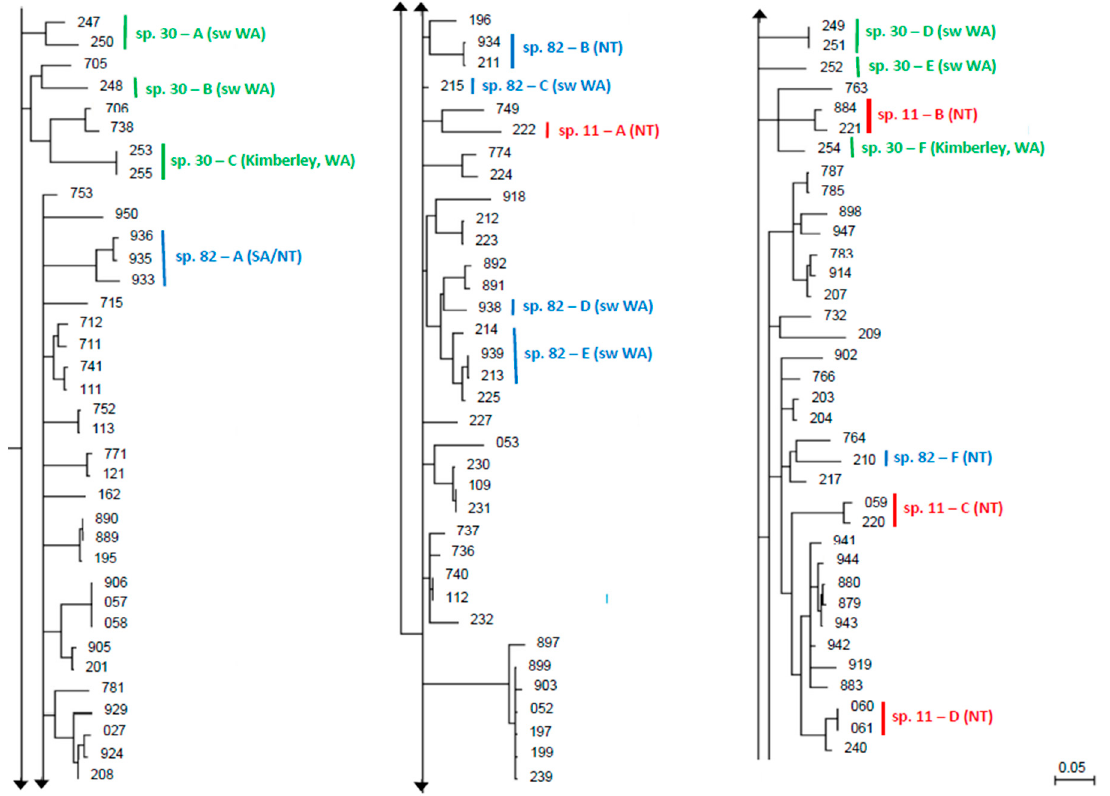
Figure 8. Extract from the full CO1 tree (Figure S1)—I. The tree indicates that sp. 11 (red), sp. 30 (green), and sp. 82 (blue) from the M. fieldi group each represent several species, as indicated by different letters. NT = Northern Territory; SA = South Australia; WA = Western Australia.